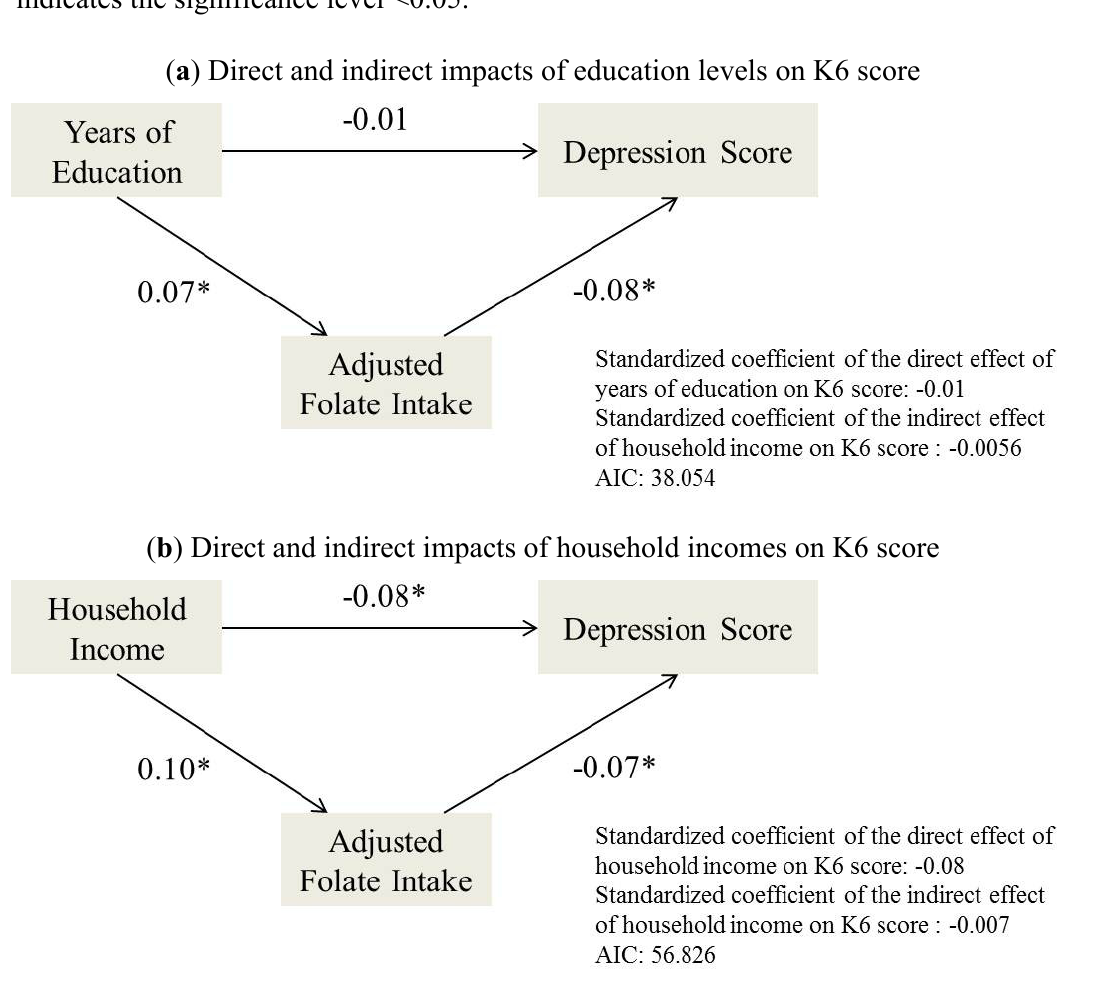
Figure 2. Path analysis of impact of folate intakes on depression scale (K6). Folate intakes are adjusted for total energy intakes. The direct standardized path coefficients are shown